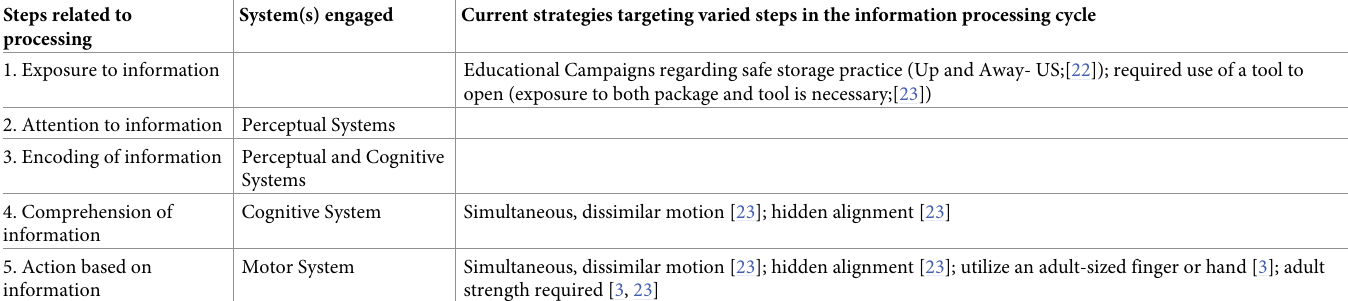
Table 1. Serialized steps of information processing (adapted from DeJoy